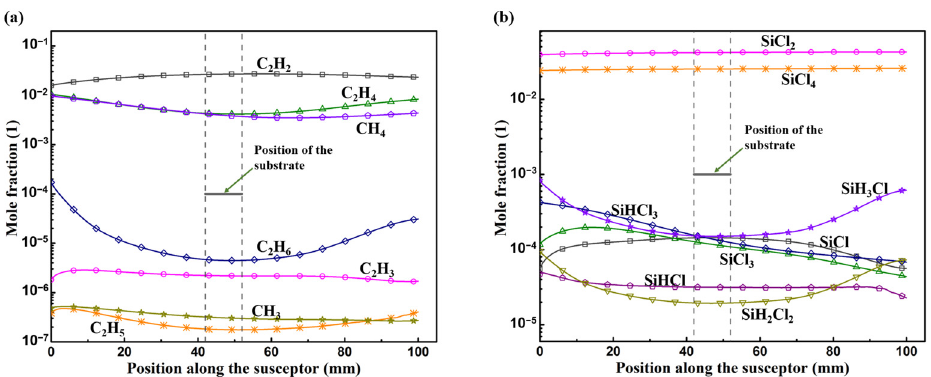
Figure 2. The mole fraction of intermediate species above the susceptor surface: ( a ) C contained species, and ( b ) Si contained species.